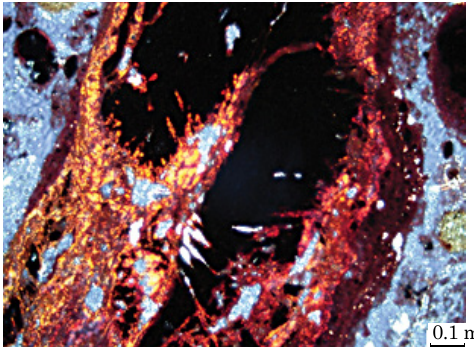
Figure 1. Thin section of the A horizon of the Petroferric Acrudox, showing the opaque cores of a dismantling ironstone, surrounded by a partially deferrified matrix (bright red and orange masses). The fragment appears to disintegrate, creating a friable outer rim of brown colors, which seems to give rise to the microgranular peds within the packing voids (blue colors). Image taken between partly crossed